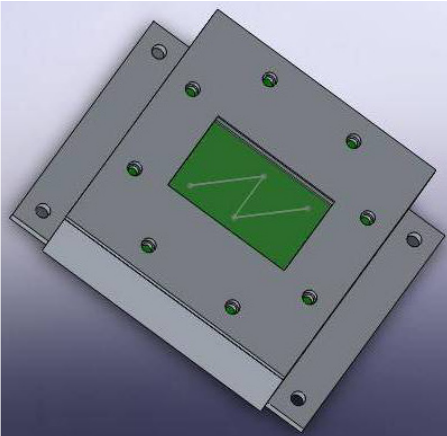
Figure 9. Outline of sun sensor prototype.